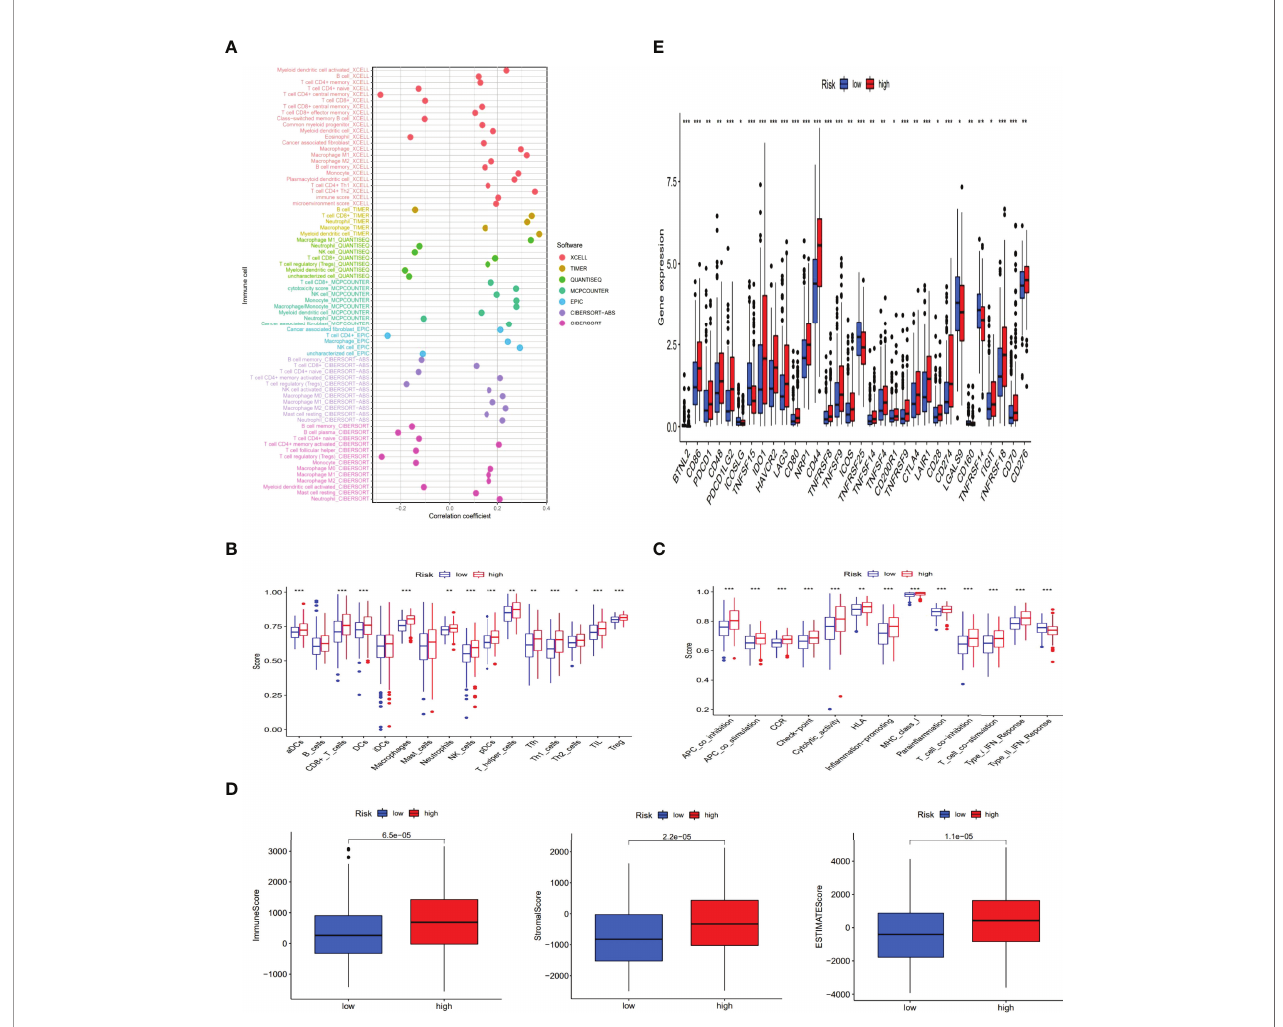
FIGURE 8 | The exploration of tumor immune characteristics and immunotherapy. The immune cell bubble of risk groups (A) . Differences of immune cells and immune function between low- and high-risk groups (B, C) . Comparison of StromalScore, ImmuneScore, and ESTIMATEScore between low and high risk groups (D) . Distinctions of 32 immune checkpoints gene expression in risk groups (E) . (*: p < 0.05, **: p < 0.01, and ***: p <